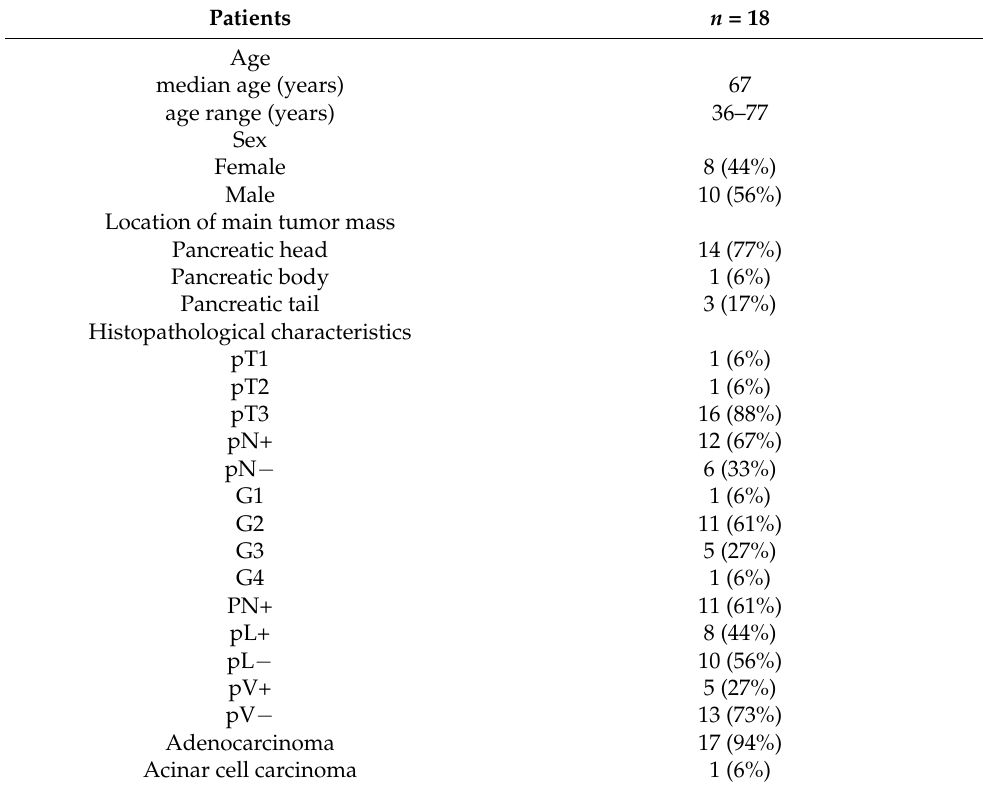
Table 1. Demographic and clinicopathological characteristics of patient